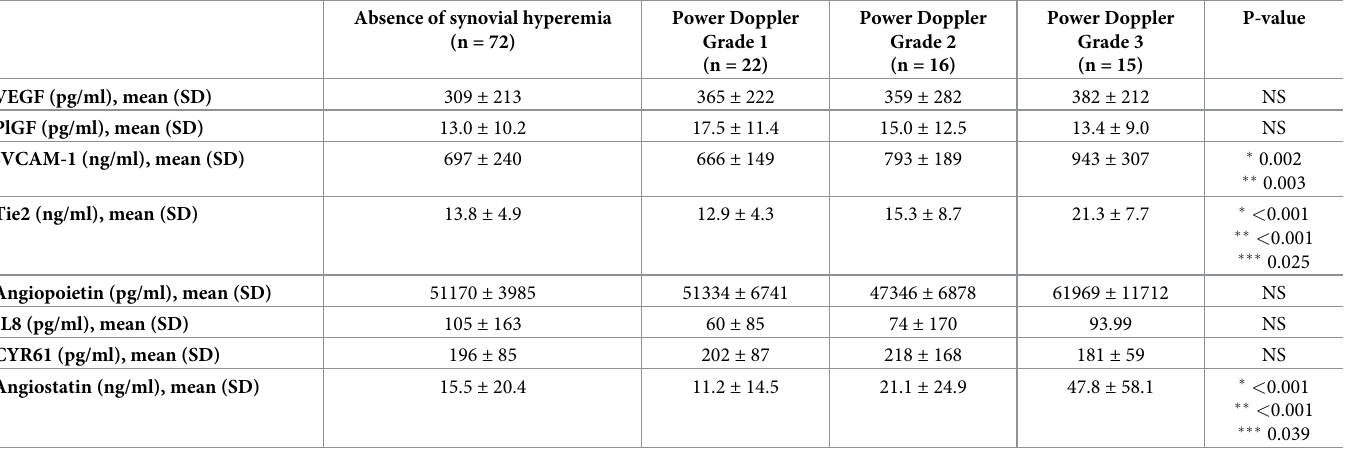
Table 2. Levels of angiogenic markers according to the intensity and extent of synovial hyperemia detected by Power Doppler.